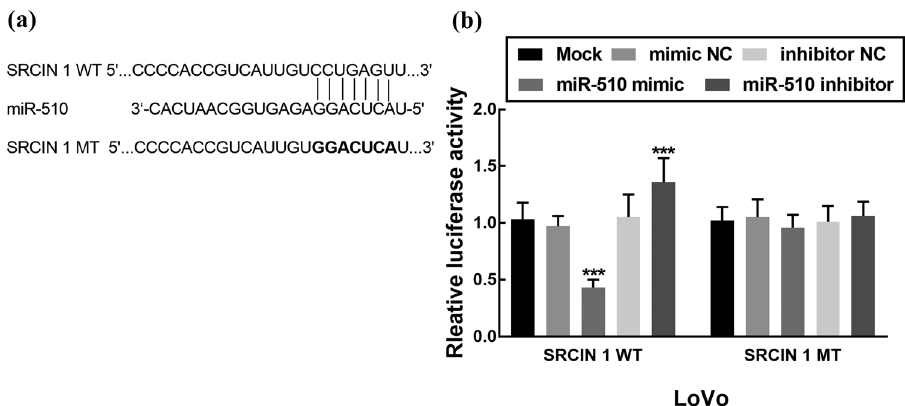
Figure 5: SRCIN 1 is the direct target of miR - 510. ( a ) The relative luciferase activity of SRCIN 1 WT was signi fi cantly inhibited by the overexpression of miR - 510 and enhanced by the silencing of miR - 510 ( *** P < 0.001 )